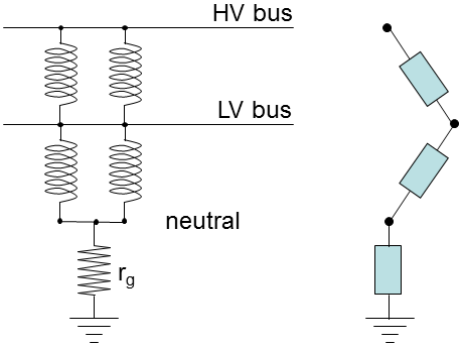
Figure 5. Scenario 2. Substation with autotransformers and equiva- lent admittances for inclusion in the network model.